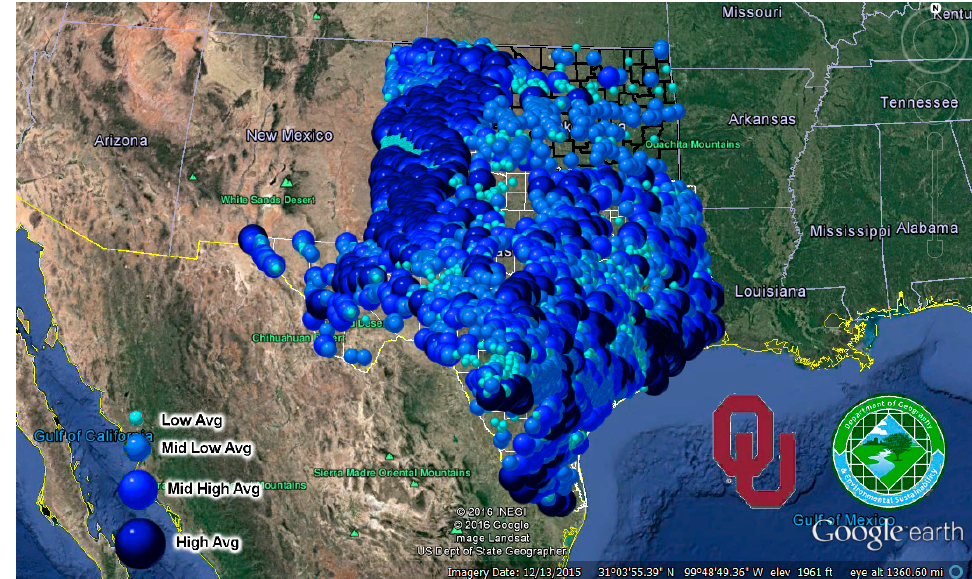
Figure 9. Screenshot of groundwater well levels in 2011–2014 in Oklahoma and Texas. Source: Authors’ calculations and visualization. Water 2017 , 9 , 117